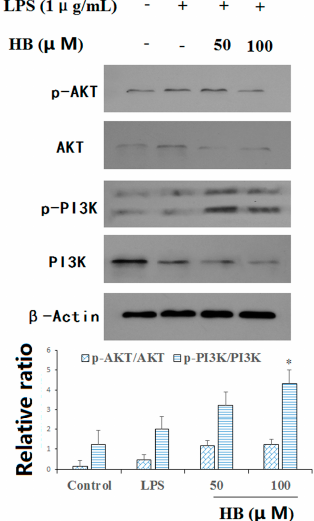
Figure 8. Effects of HB on LPS-induced PI3K and AKT phosphorylation. RAW 264.7 cells were pretreated with 50 and 100 µ M HB for 1 h before treatment with 1 µ g/mL LPS. After incubation for 30 min, the expression of levels of PI3K and AKT protein were measured by western blot analysis. The values are presented as means ± SD of three independent experiments. * p < 0.05, compared to the LPS-treated